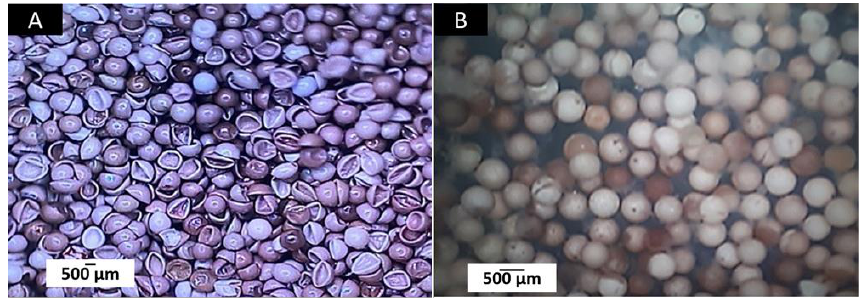
Figure 4. Cysts and larvae of Artemia salina. ( A ) Dry cysts at 3×. ( B ) Hydrated cysts at 24 h at 3×. Images were taken with a stereoscopic microscope.